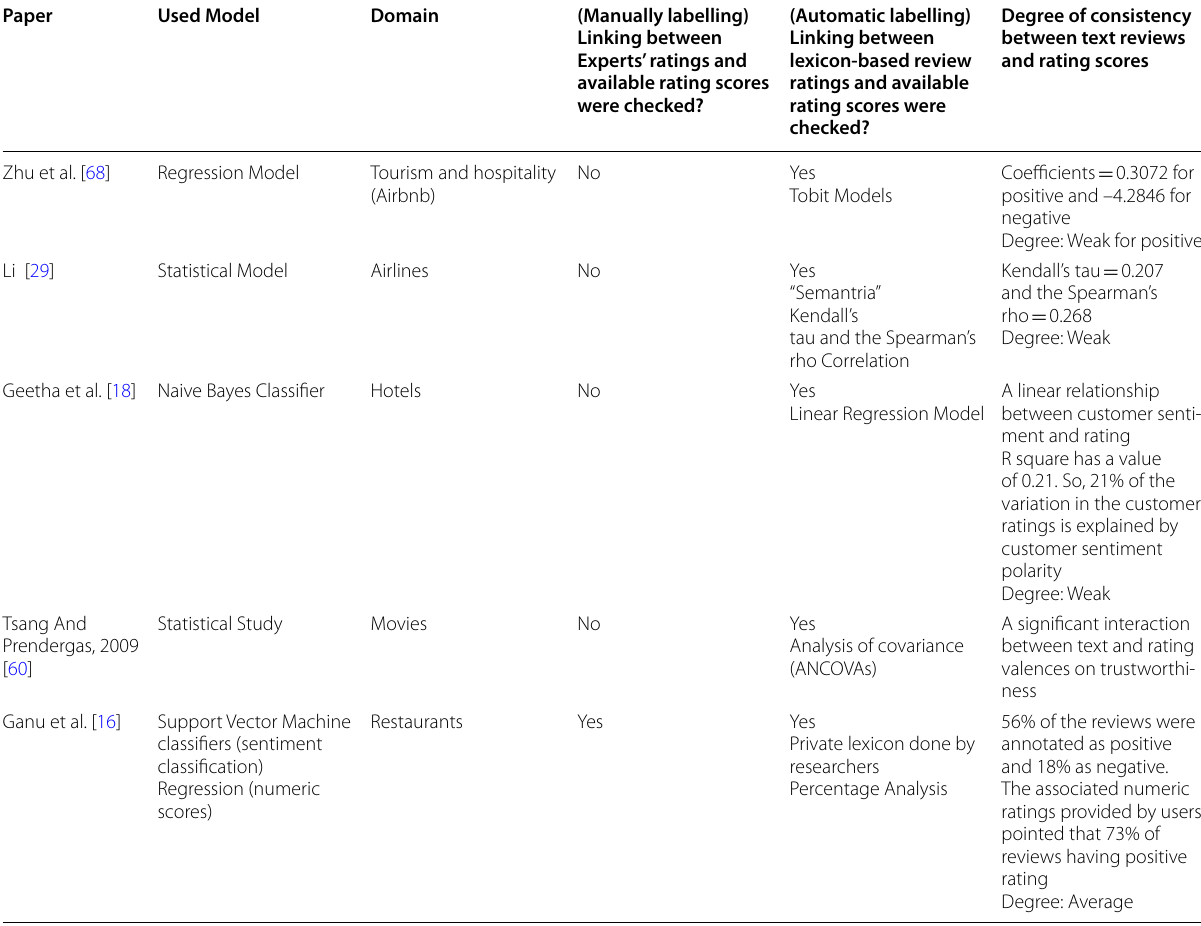
Table 2 Summary of the reviewed papers which examine the relationship between numeric ratings and texts reviews in prediction models